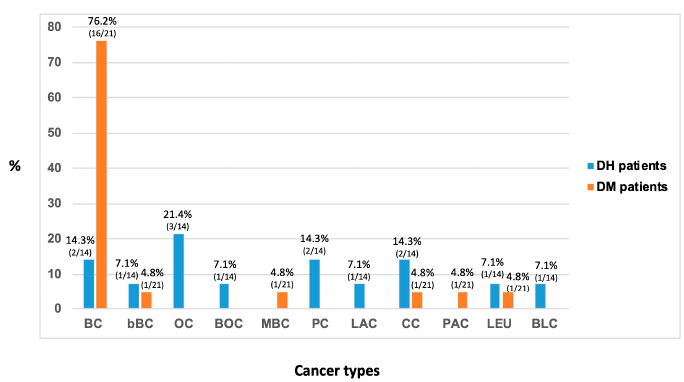
Figure 6. Cancer types occurring in families with DH and DM. BC: breast cancer; bBC: bilateral breast cancer; OC: ovarian cancer; BOC: breast ovarian cancer; MBC: male breast cancer; PC: prostate cancer; LAC: laryngeal cancer; CC: colon cancer; PAC: pancreatic cancer; LEU: leukemia; BLC: bladder cancer.